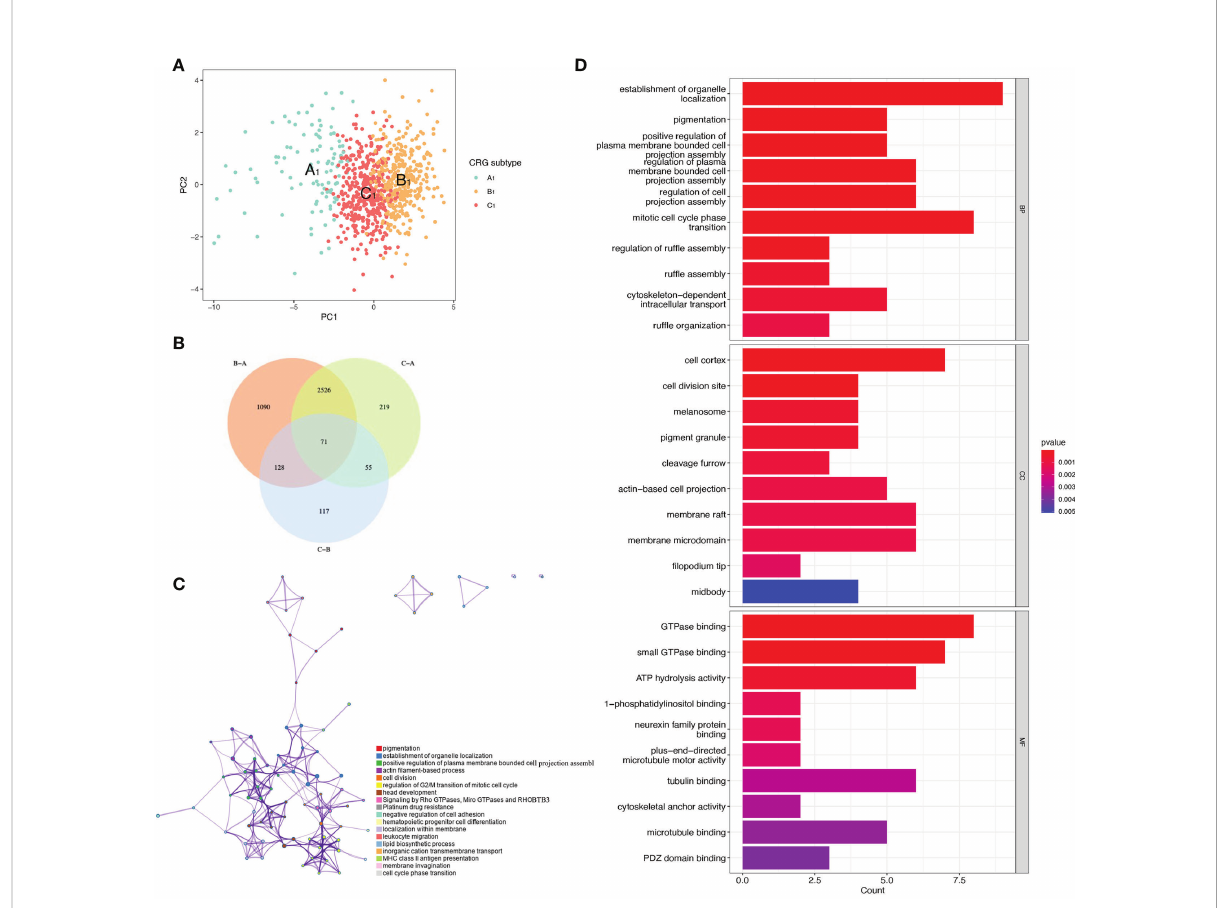
FIGURE 3 Differentially expressed genes of three CRGs molecular subtypes. (A) VENN plot showing 71 intersecting differentially expressed genes across three molecular subtypes. (B) t-distributed Stochastic Neighbor Embedding (tSNE) analysis of three CRGs molecular subtypes. (C) Metascape enrichment analysis of DEGs with intersections of the three molecular subtypes. (D) GO enrichment analysis of DEGs with intersections of the three molecular